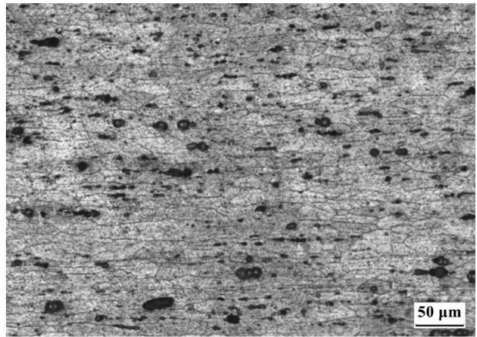
Figure 4. Microstructure of the base material used in this study.